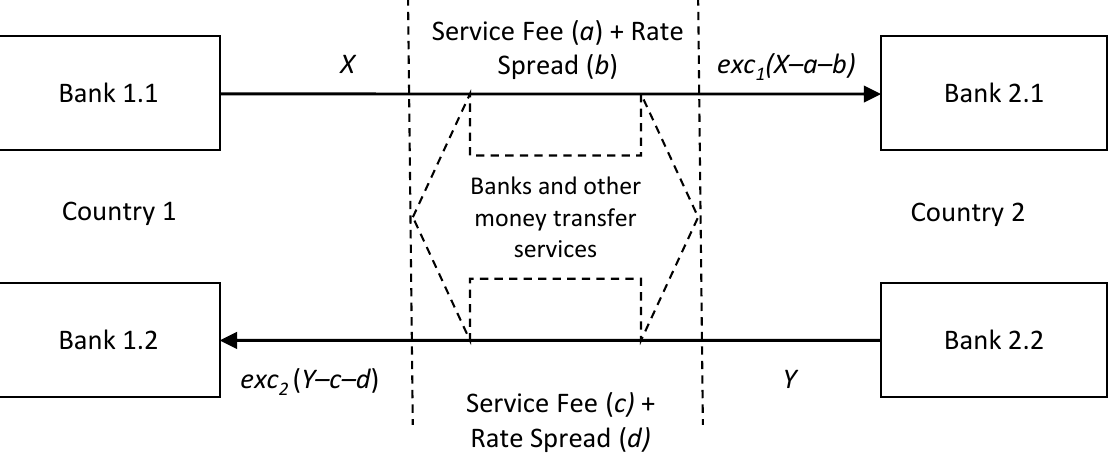
Figure 4. Regular cross-border payment